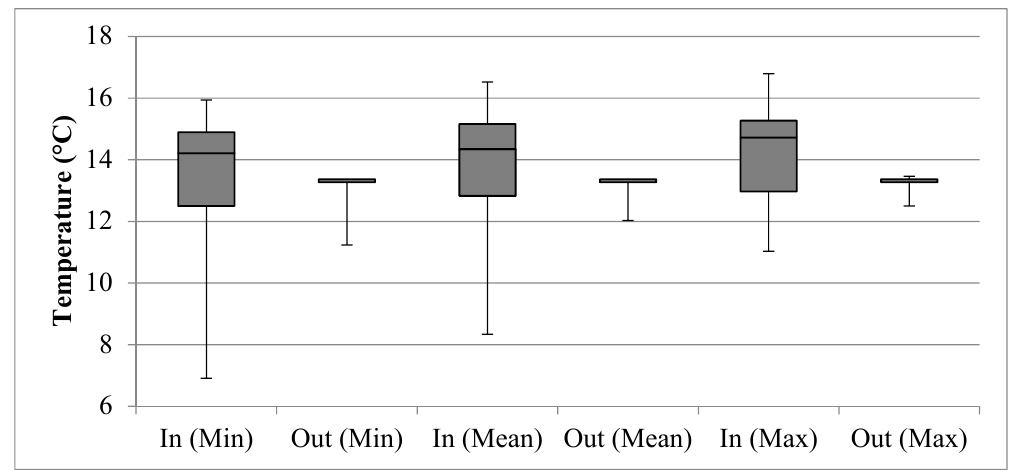
Figure 6. Fall (October and November) inlet and outlet temperature during runoff events: minimum, mean and maximum.